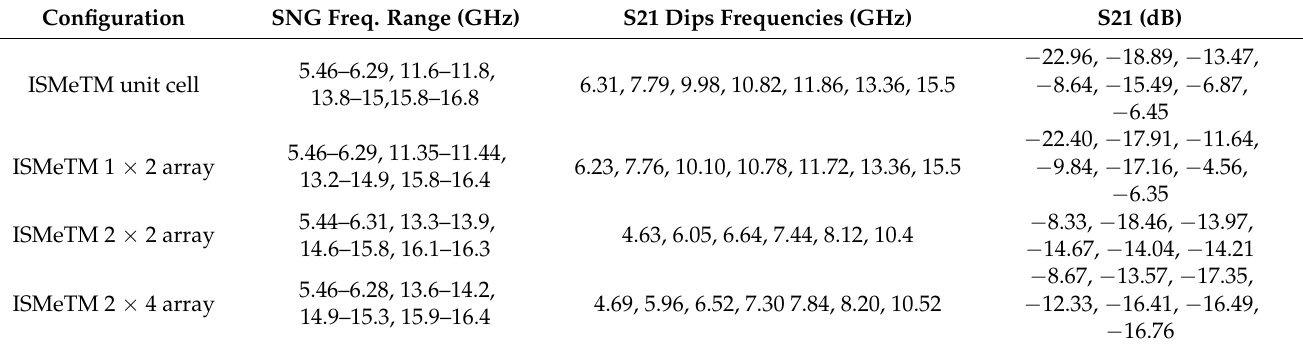
Table 3. Parameters of ISMeTM unit cell, ISMeTM 1X2 array, ISMeTM 2X2 array and ISMeTM 2X4 array. Configuration